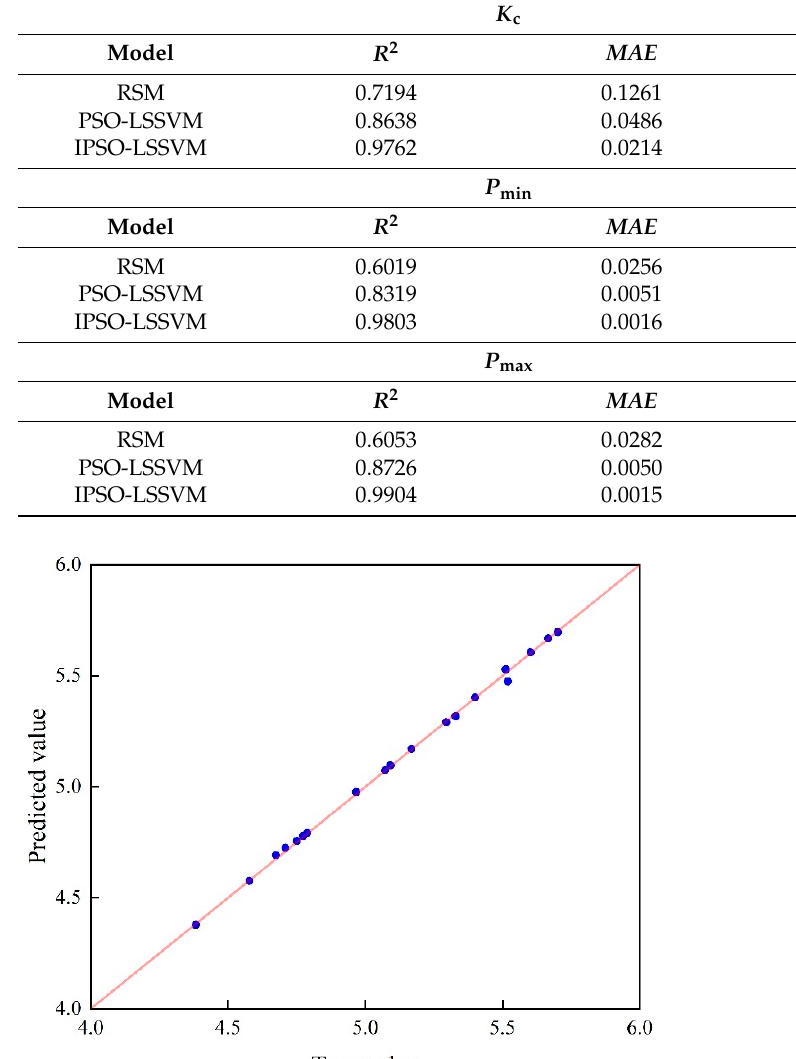
Figure 9. Comparison between the predicted and true value of P min .